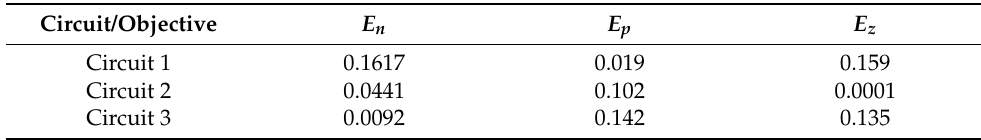
Table 10. Sub-objective values for different